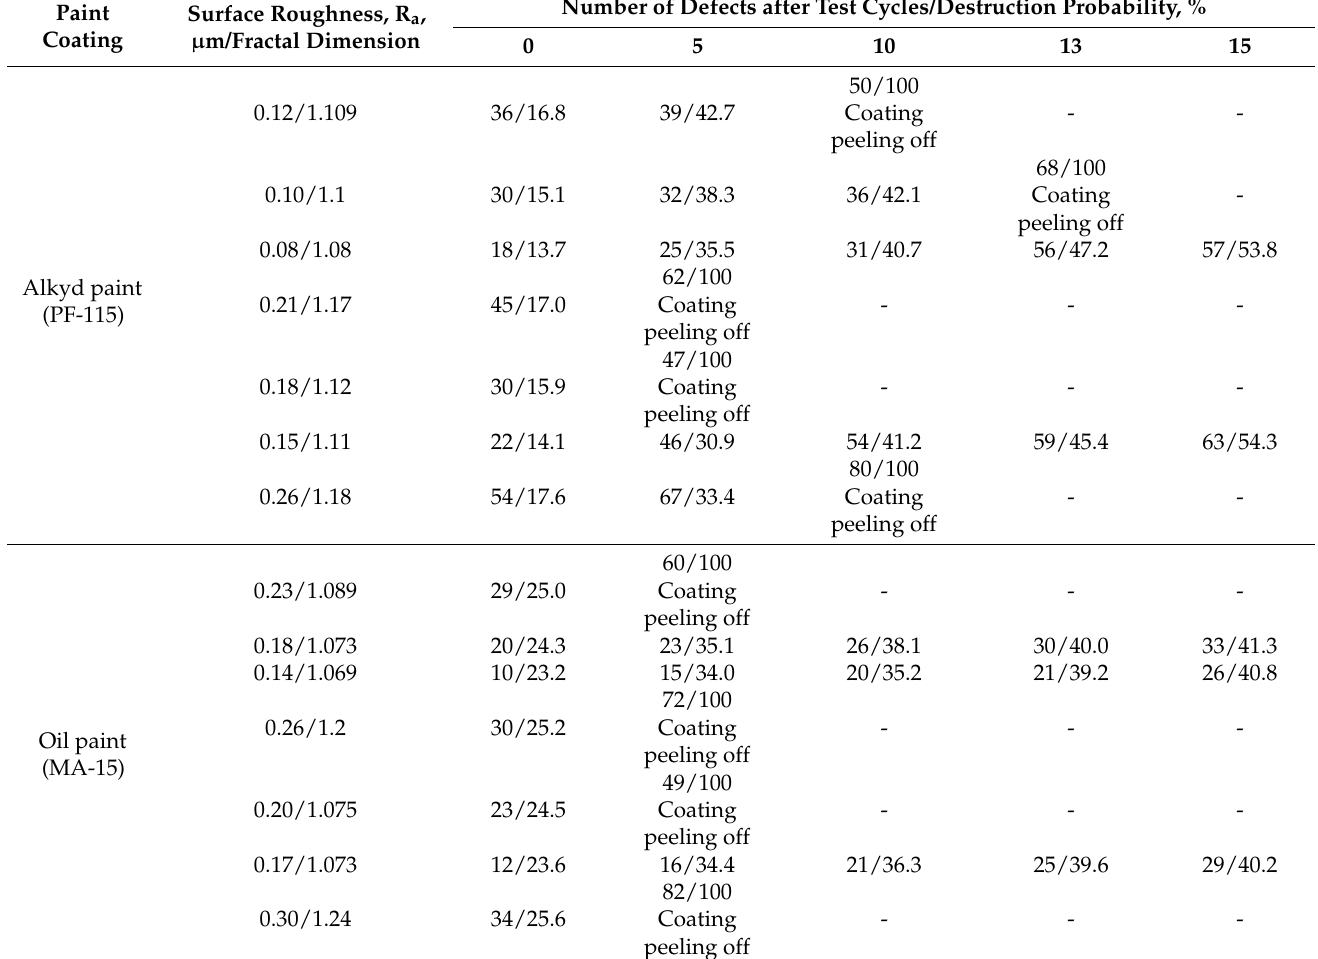
Table 4. Change in the quality of the appearance of coatings in the process of